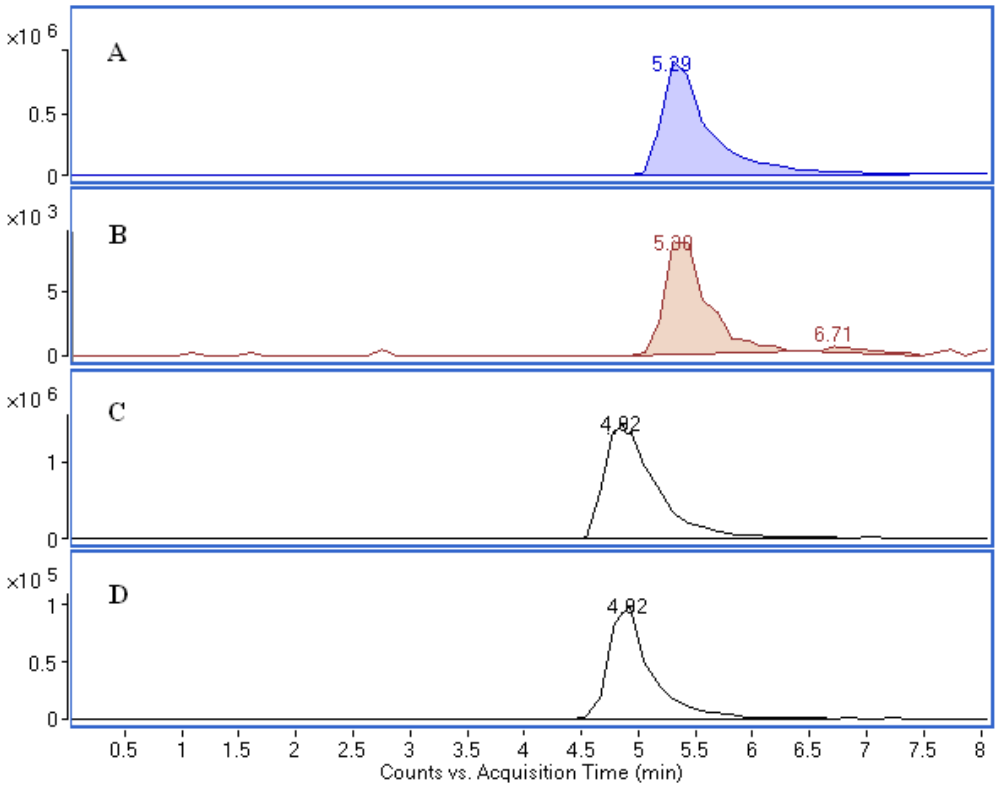
Figure 9. Detection of xylose and rhamnose in the degradation products by negative-mode LC/ESI-Q-TOF-MS. Extracted ion chromatograms (EIC) for xylose [M − H] − 149.0455 and rhamnose [M − H] − 163.0612. ( A ) xylose standard, ( B ) degradation products of compound 1 , ( C ) rhamnose standard, and ( D ) degradation products of compound 2 .